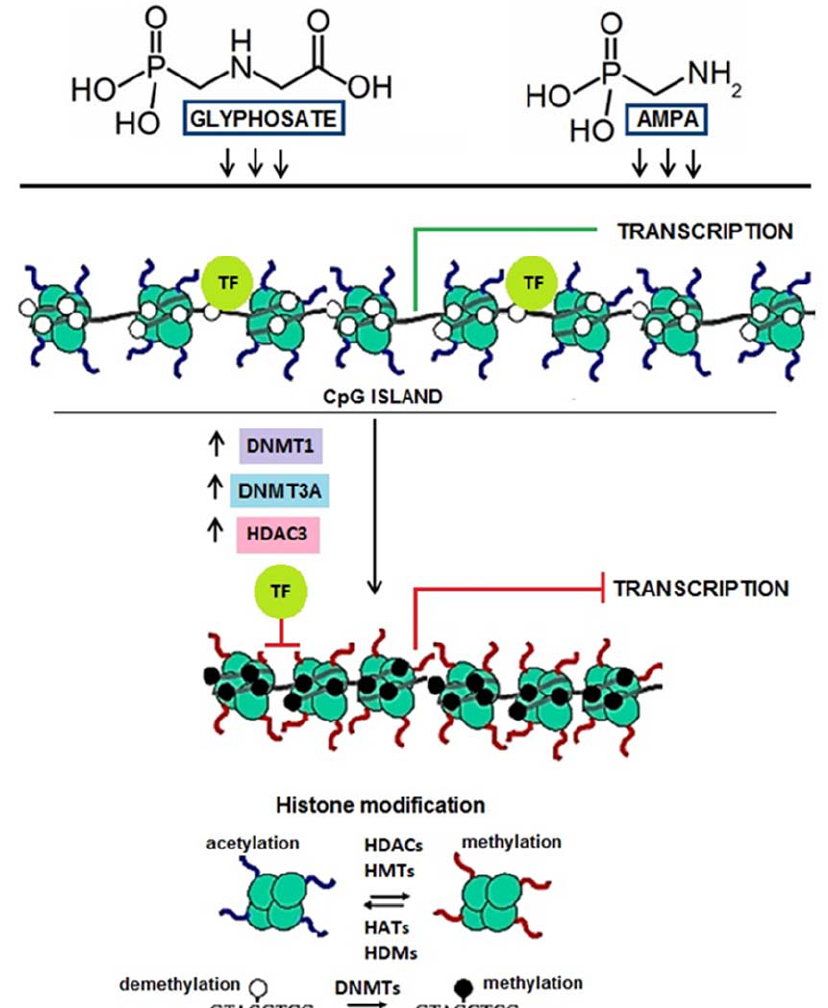
Figure 4. The potential impact of glyphosate and AMPA on chromatin structure. Chromatin plays a crucial role in gene activation and inhibition by regulating the accessibility of transcription factor (TG) binding. Methyl groups are coupled to cytosines by the family of DNA methyltransferases (DNMTs), where DNMT1 is the main maintenance enzyme and the DNMT3A branch of the family is mostly responsible for de novo